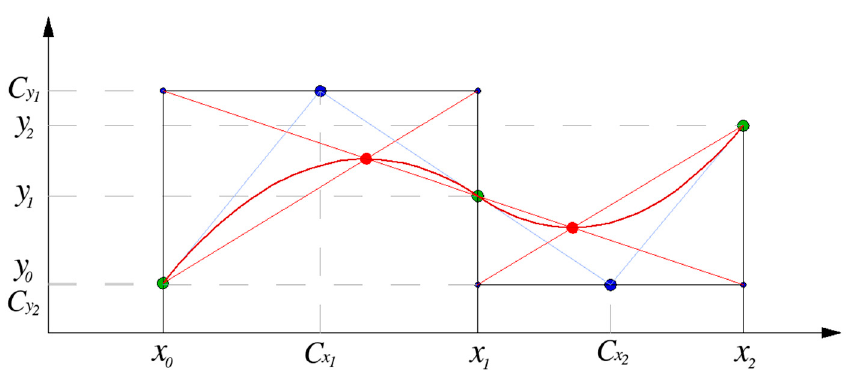
Figure 11. Second parabola within the interval [ x 1 , x 2 ] , smoothly connected to the previous one. The extrema of the parabolas are marked with a red dot, the control points with a blue dot, and the green dots indicate points to be interpolated.